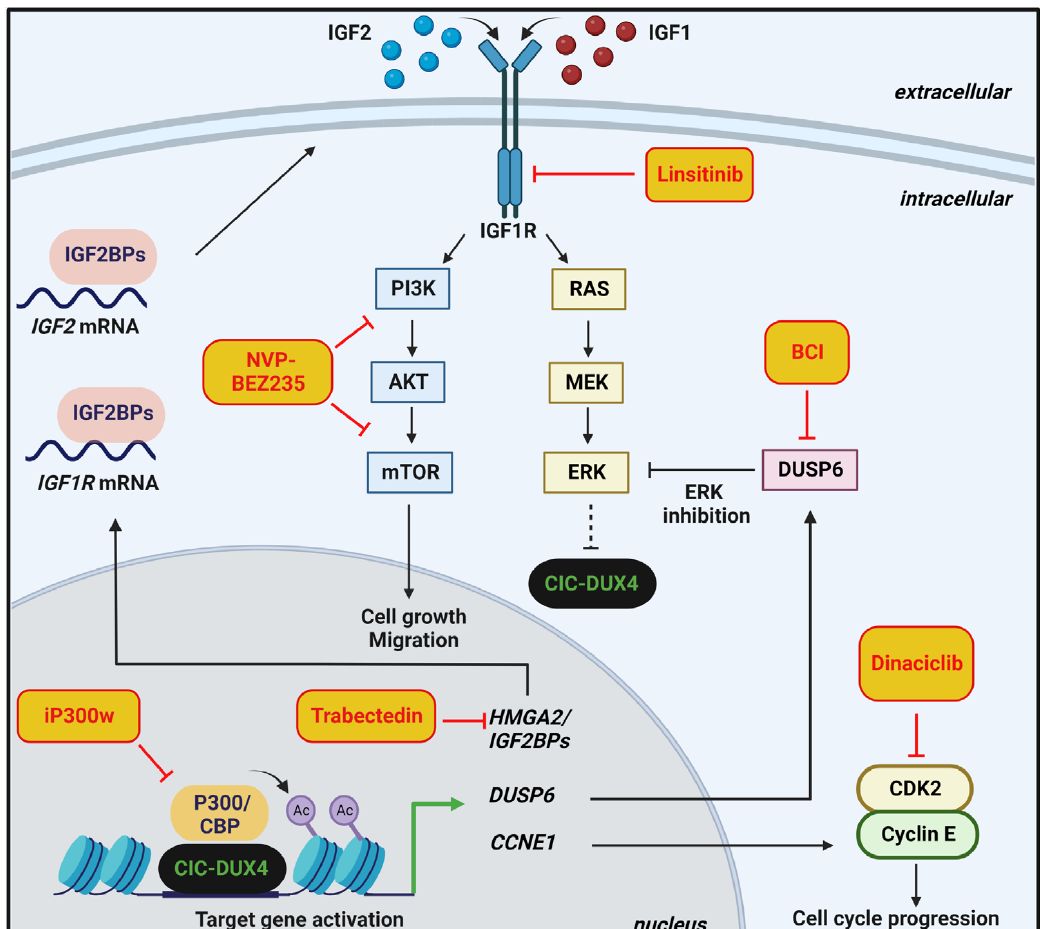
Figure 3. Schematic representation of CIC–DUX4-mediated oncogenic functions and related therapeutic implications in cancer. In the nucleus, CIC–DUX4 interacts with P300/CBP to induce histone H3 acetylation and transcription activation of target genes including HMGA2/IGF2BPs axis,